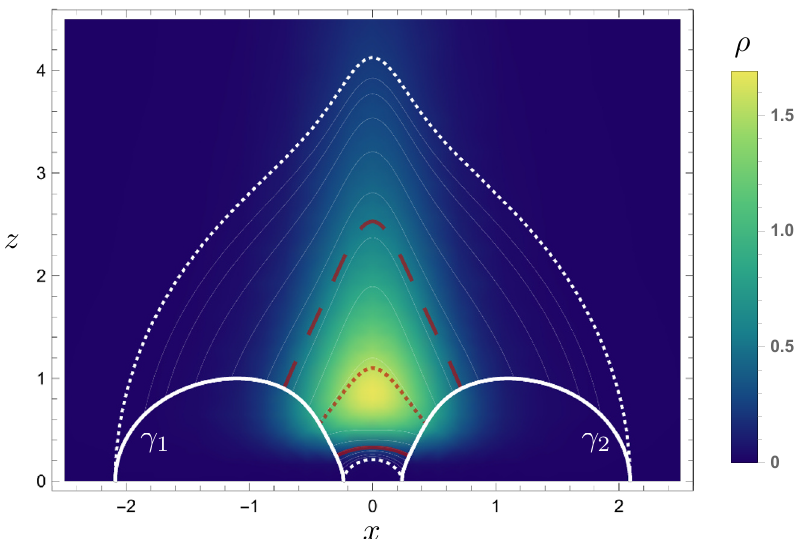
Figure 7 . Construction of a Python’s Lunch wormhole, using the metric in eq. (2.3) with dust density (cid:26) given in eq. (5.2). The boundary anchored geodesics (cid:13) 1 ; 2 are identi(cid:12)ed (thick white lines). The wormhole region lies between the geodesics subtending regions A and B (dotted white lines). The circumference of the wormhole at a given a(cid:14)ne parameter is found from the length of the geodesic connecting the analogous points on (cid:13) 1 ; 2 ; examples are shown by the thin, translucent lines. This circumference exhibits three extrema (red lines): two minima (solid and dashed), one of which is the entanglement wedge cross section (solid), and one local maximum (dotted), which constitutes the bulge of the Python’s